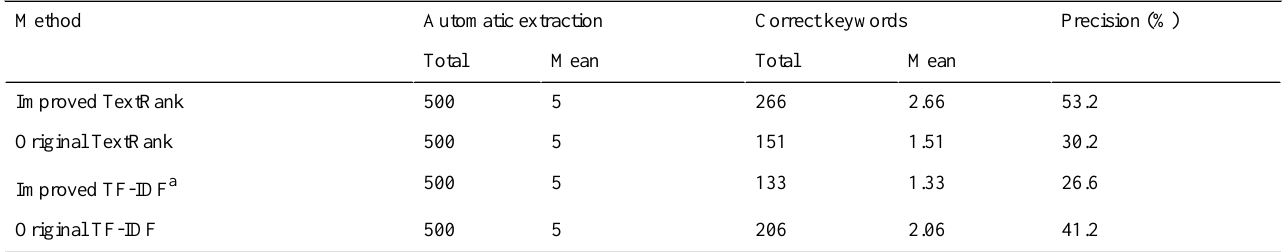
Table 4. Results for automatic keyword extraction using different algorithms.